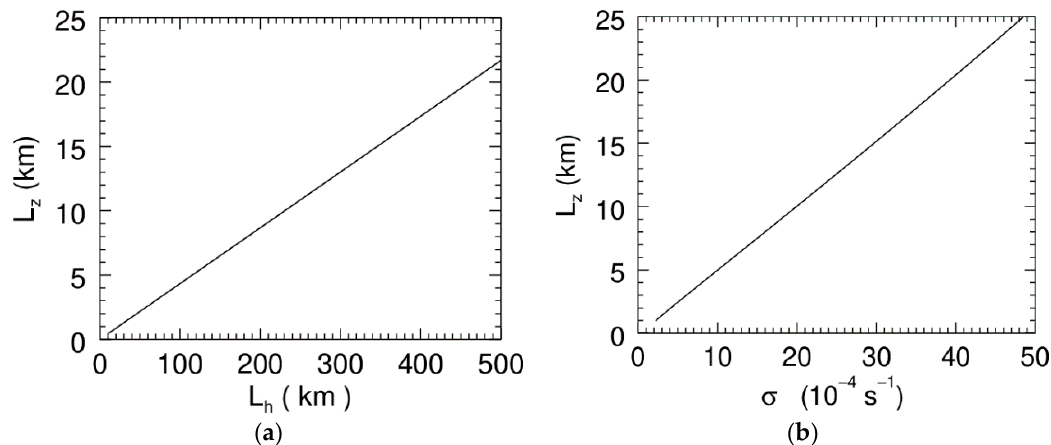
Figure 2. Relationship between the vertical wavelength of the forced gravity wave (FGW) and ( a ) the horizontal wavelength and ( b )